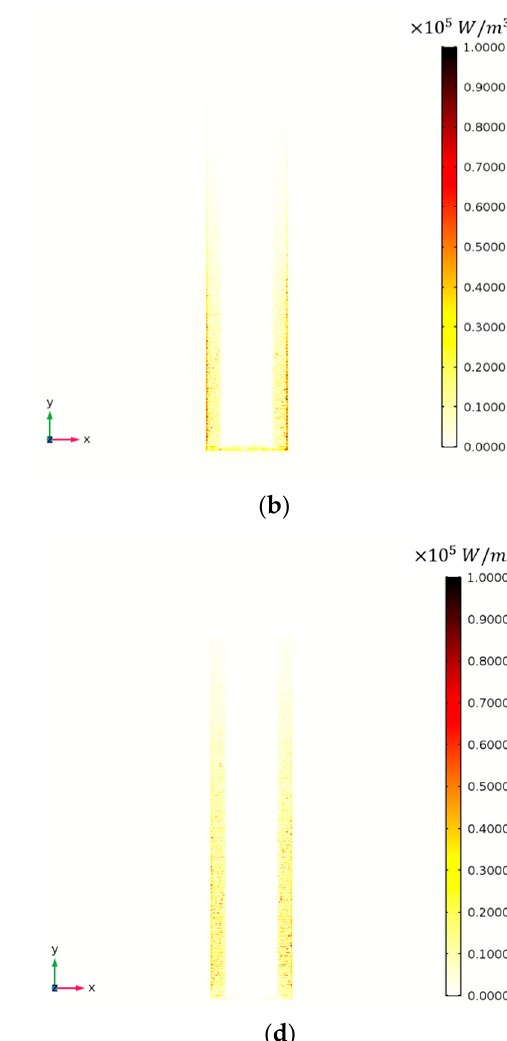
slotted MCL in 1st Bending mode, ( b ) Viscous dissipation density around the slotted MCL with edge